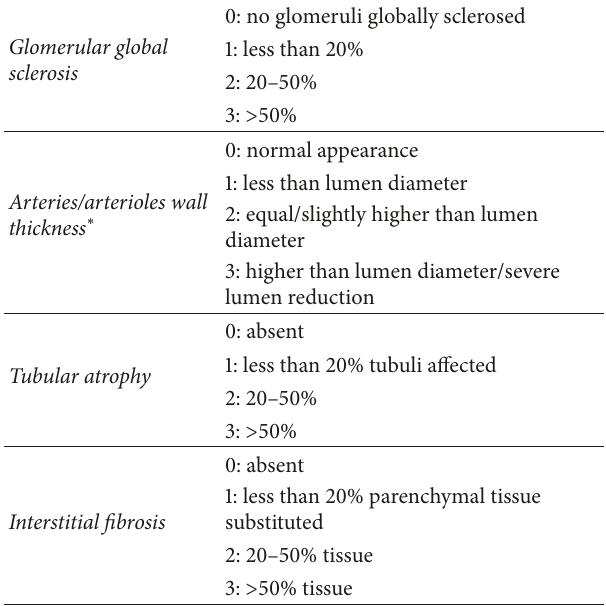
Table 1: Histologic score in use for kidney allocation to SKT or DKT of “high-risk”